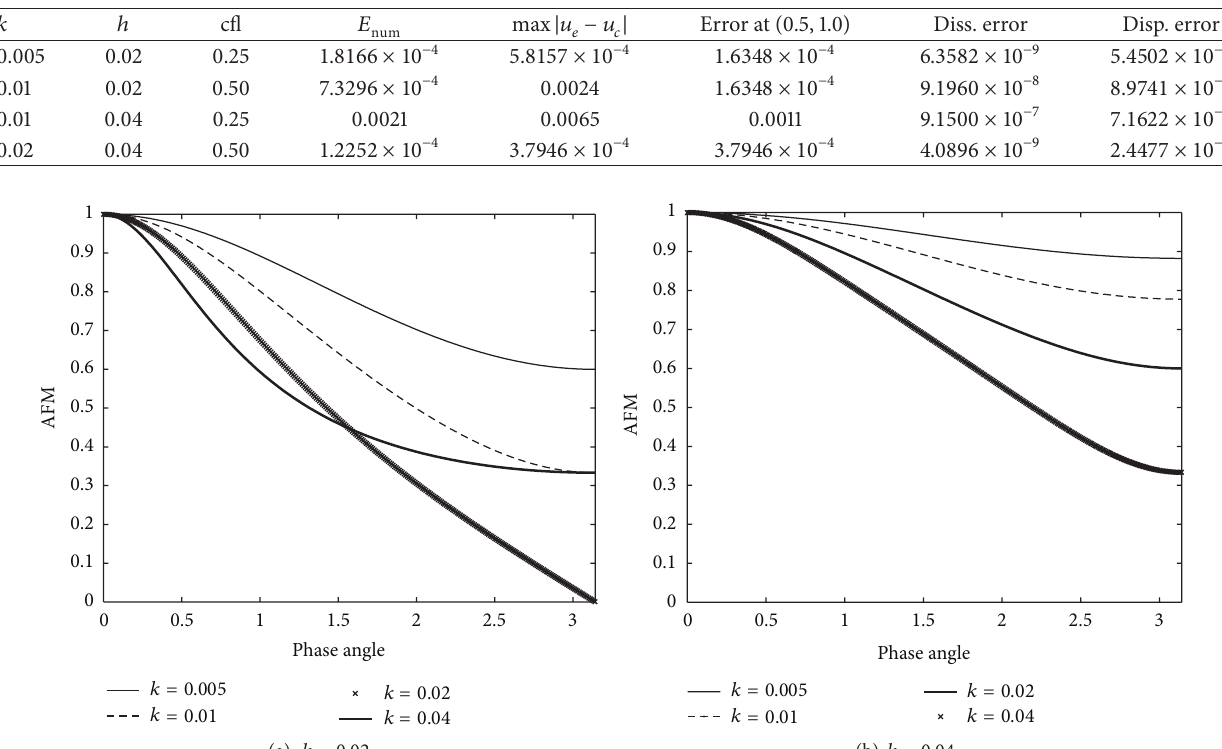
Table 1: Errors for Lax-Wendroff scheme.